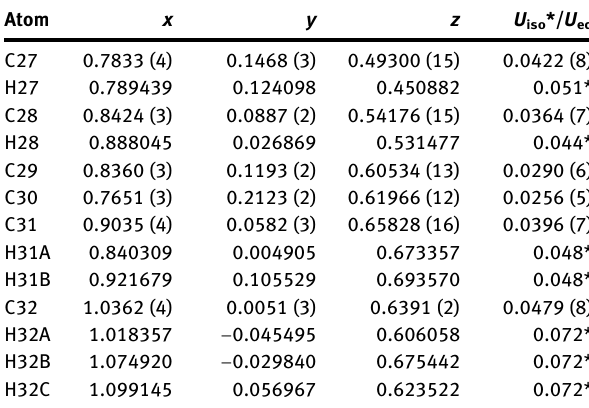
Table  : Fractional atomic coordinates and isotropic or equivalent isotropic displacement parameters (Å 